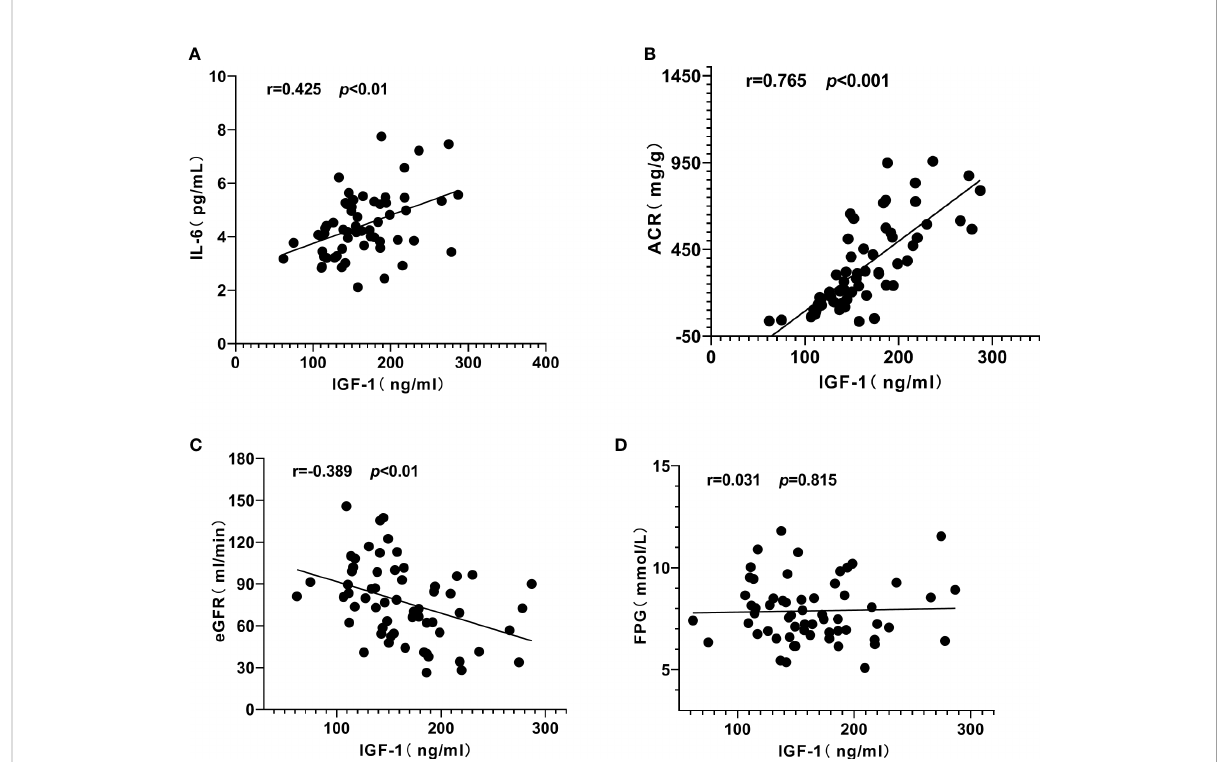
FIGURE 3 Correlation analysis of serum insulin-like growth factor-1 (IGF-1) with interleukin-6 (IL-6), urinary albumin/creatinine ratio (ACR) and estimated glomerular fi ltration rat (eGFR) in patients with diabetic kidney disease (DKD). (A) IGF-1 was positively correlated with IL-6. (B) IGF-1 was positively correlated with ACR. (C) IGF-1 was negatively correlated with eGFR. (D) IGF-1 had no signi fi cant correlation with fasting plasma glucose